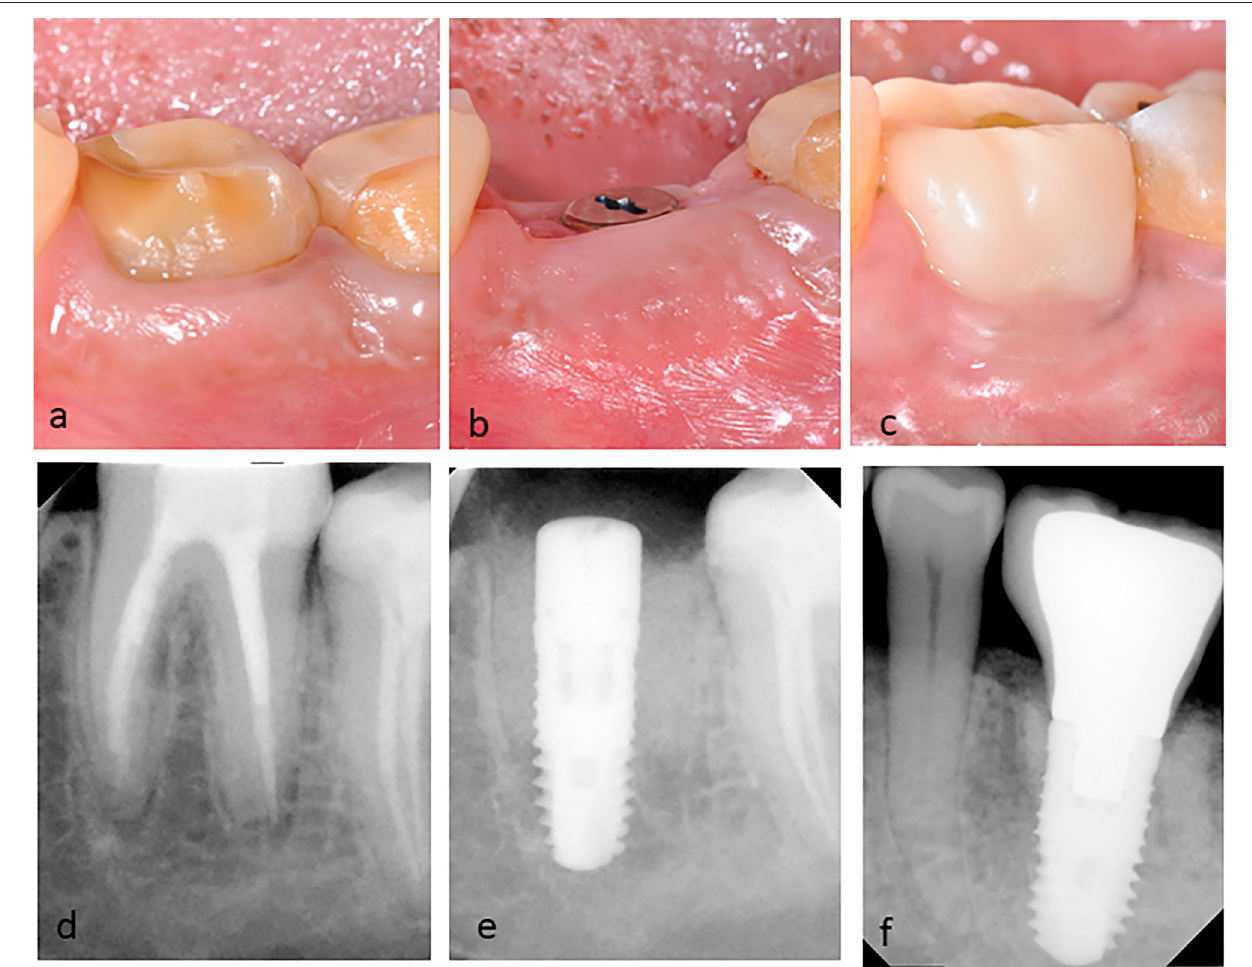
FIGURE 4 | Clinical and radiographic images of the mandibular left fi rst molar with failed endodontic treatment. (A) Preoperative clinical lateral view; (B) postoperative clinical lateral views after 3 months of implant placement; (C) clinical picture of de fi nitive porcelain fused to the metal screw-retained implant crown at three-year follow-up; (D) Preoperative periapical radiograph; (E) periapicalradiographs oftheimplant after3 months;and (F) radiographic imageat three-year follow-up showing the marginal bone level.